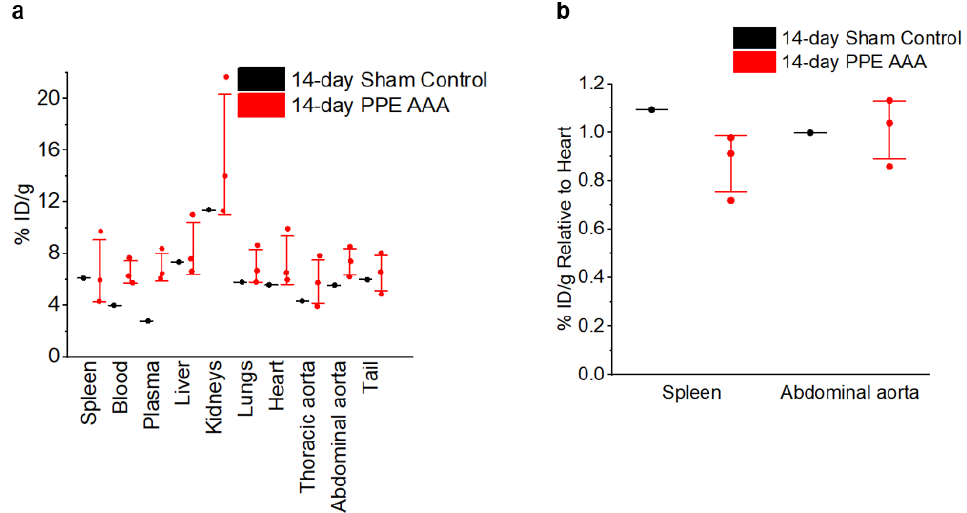
Figure 4. Decay-corrected ex vivo [ 18 F]FLT counts per mass units. ( a ) All organs. ( b ) Uptake in the spleen and abdominal aorta normalised to uptake in the heart.